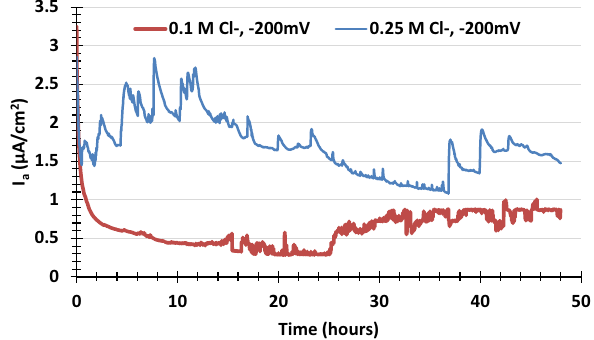
Figure 8: Anodic current density ( I a ) of HSHCsw at 0.1 and 0.25 M Cl − when the AP is polarized at − 200 mV ( in the zone of no pitting corrosion in Figure 7 ) , in the deaerated electrolyte at pH